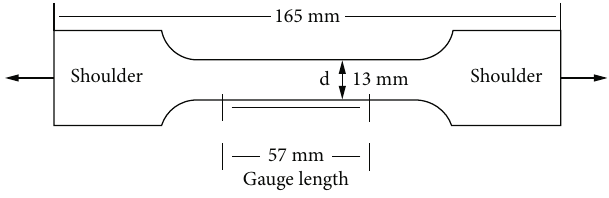
Figure 3: Dumbbell type specimen for tensile Table 3: Dimensions of GO-GFN bearing.